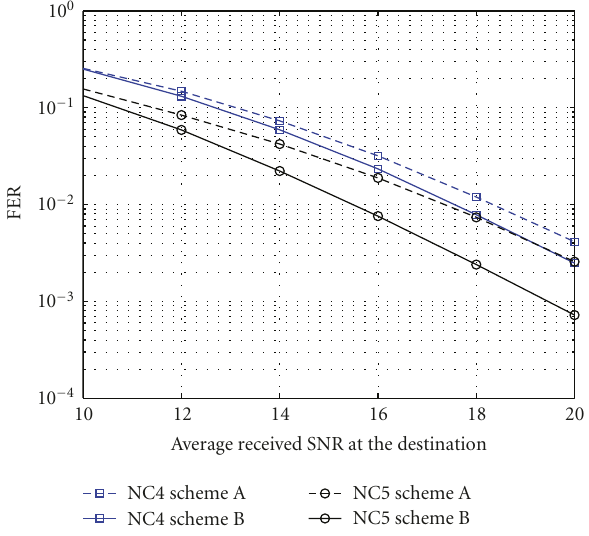
Figure 11: FER performances of 8PSK codes for Scheme B (dSNR =